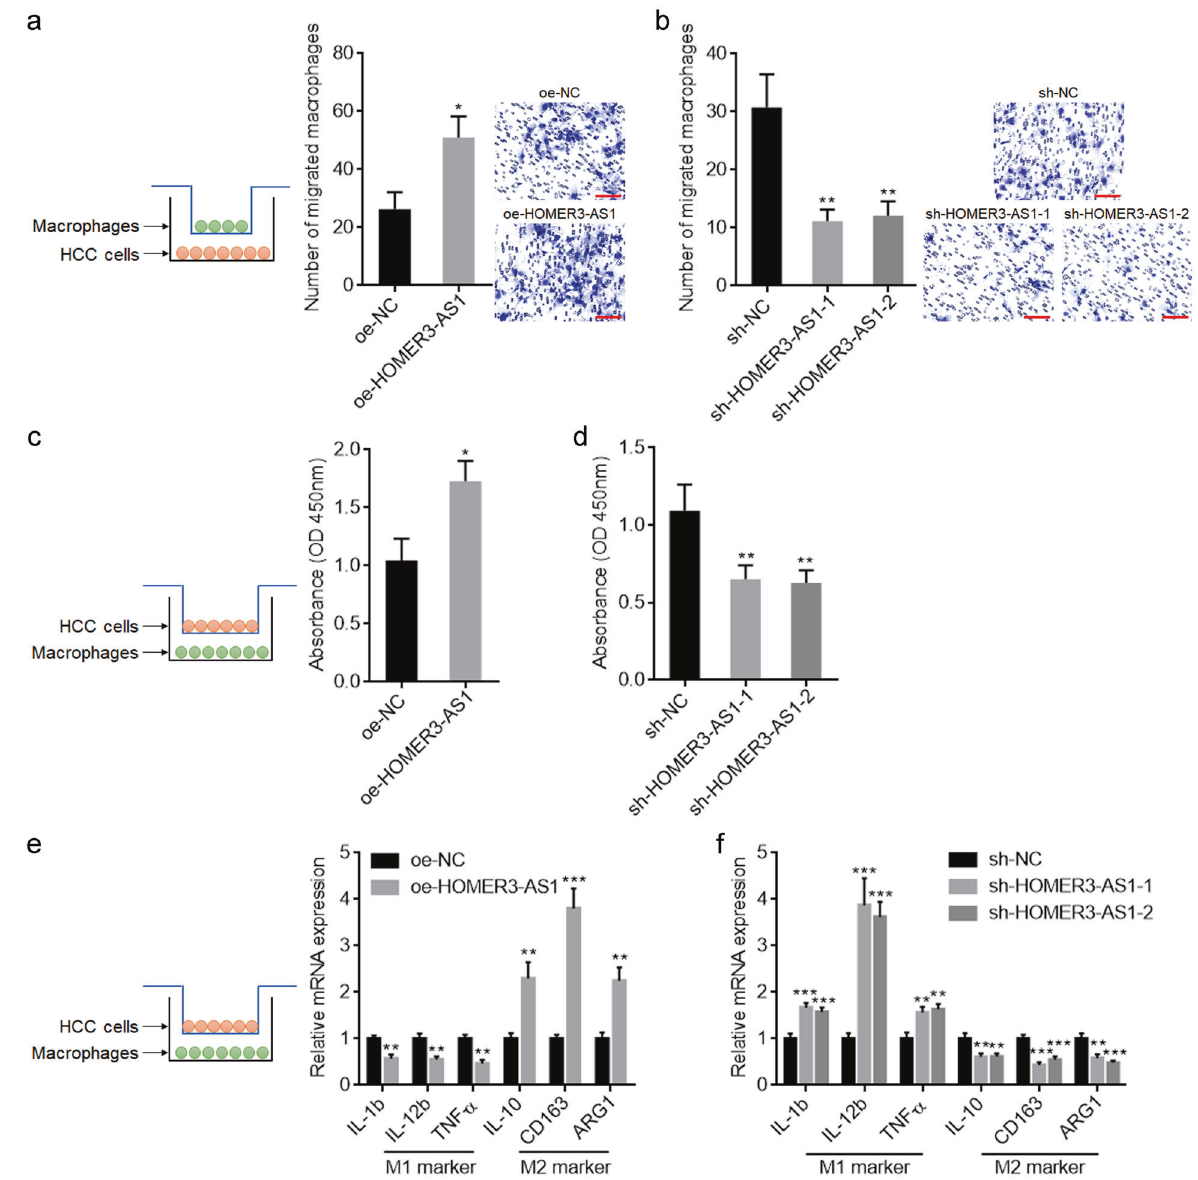
Fig. 6 HOMER3-AS1 promoted macrophages in fi ltration and M2-like polarization. a PMA-stimulated THP-1 cells were subjected to migration assays towards SK-HEP-1 cells with HOMER3-AS1 overexpression or control. b PMA-stimulated THP-1 cells were subjected to migration assays towards SK-HEP-1 cells with HOMER3-AS1 silencing or control. c Cell proliferation of PMA-stimulated THP-1 cells co-cultured with HOMER3-AS1 overexpressed or control SK-HEP-1 cells was determined by CCK-8 experiments. d Cell proliferation of PMA-stimulated THP- 1 cells co-cultured with HOMER3-AS1 silenced or control SK-HEP-1 cells was determined by CCK-8 experiments. e Expression of markers associated with M1 and M2 polarization in PMA-stimulated THP-1 cells co-cultured with HOMER3-AS1 overexpressed or control SK-HEP-1 cells was detected by qRT-PCR. f Expression of markers associated with M1 and M2 polarization in PMA-stimulated THP-1 cells co-cultured with HOMER3-AS1 silenced or control SK-HEP-1 cells was detected by qRT-PCR. Results are presented as mean ± SD based on three independent experiments. * p < 0.05, ** p < 0.01, *** p < 0.001 by Student ’ s t -test ( a , c , e ) or one-way ANOVA followed by Dunnett ’ s multiple comparisons test ( b , d , f ). (Fig. 7e – g). Anti-CSF-1 treatment reversed HOMER3-AS1-induced cells with HOMER3-AS1 overexpression had increased CSF-1 macrophages migration, proliferation, and M2 polarization secretion compared with control cells (Fig. 7c). Conversely, (Fig. 7e – g). Collectively, these data suggested that HOMER3-AS1 HOMER3-AS1 silencing reduced CSF-1 secretion (Fig. 7d). To upregulated CSF-1 expression and secretion, which further elucidate whether the induced secretion of CSF-1 by HOMER3-AS1 induced macrophages recruitment and M2-like polarization. mediates the roles of HOMER3-AS1 in inducing macrophages in fi ltration and polarization, conditioned medium (CM) from SK- HEP-1 cells with HOMER3-AS1 overexpression or control was used DISCUSSION to stimulate PMA-treated THP-1 cells. Similar with co-culture, CM Increasing understandings of the crosstalk between tumor cells from HOMER3-AS1 overexpressed SK-HEP-1 cells also promoted and tumor microenvironment (TME) have driven advances in macrophages migration, proliferation, and M2 polarization Cell Death and Disease (2021)